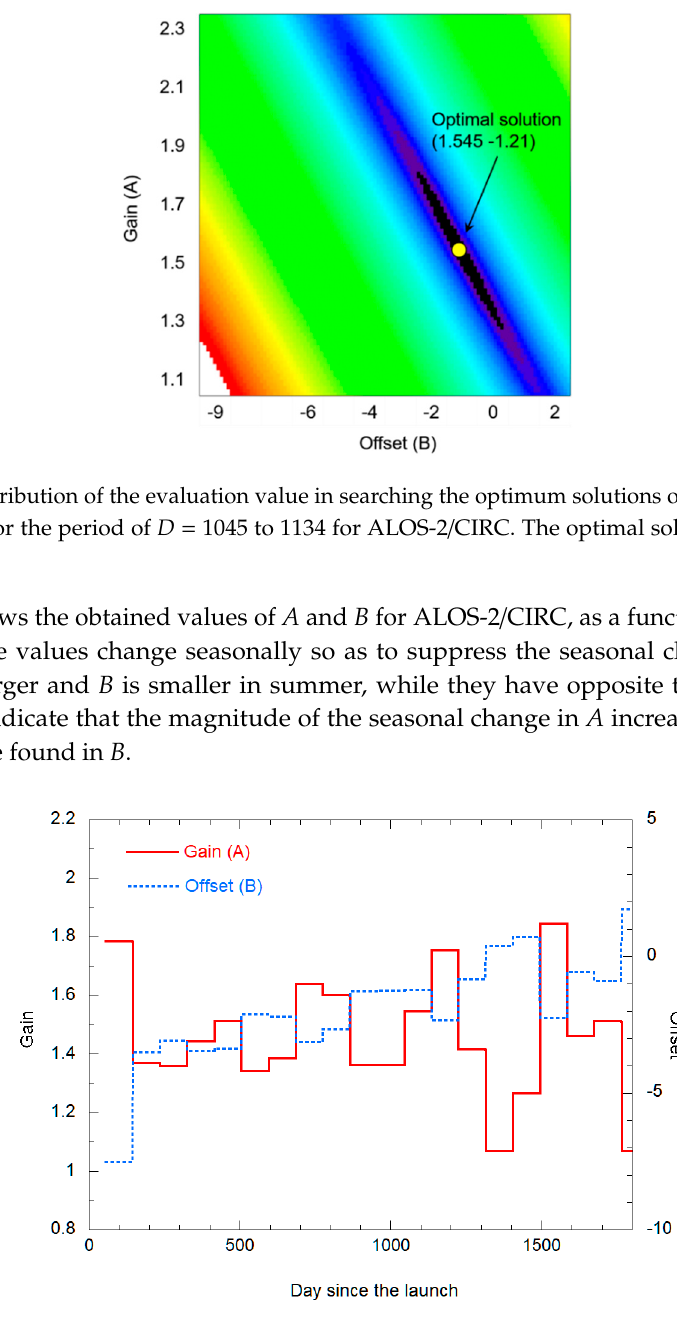
Figure 16. Gain and offset for recalibrating the ground testing-based radiance ( R 0 ) for ALOS-2/CIRC as a function of the day since the launch ( D ).